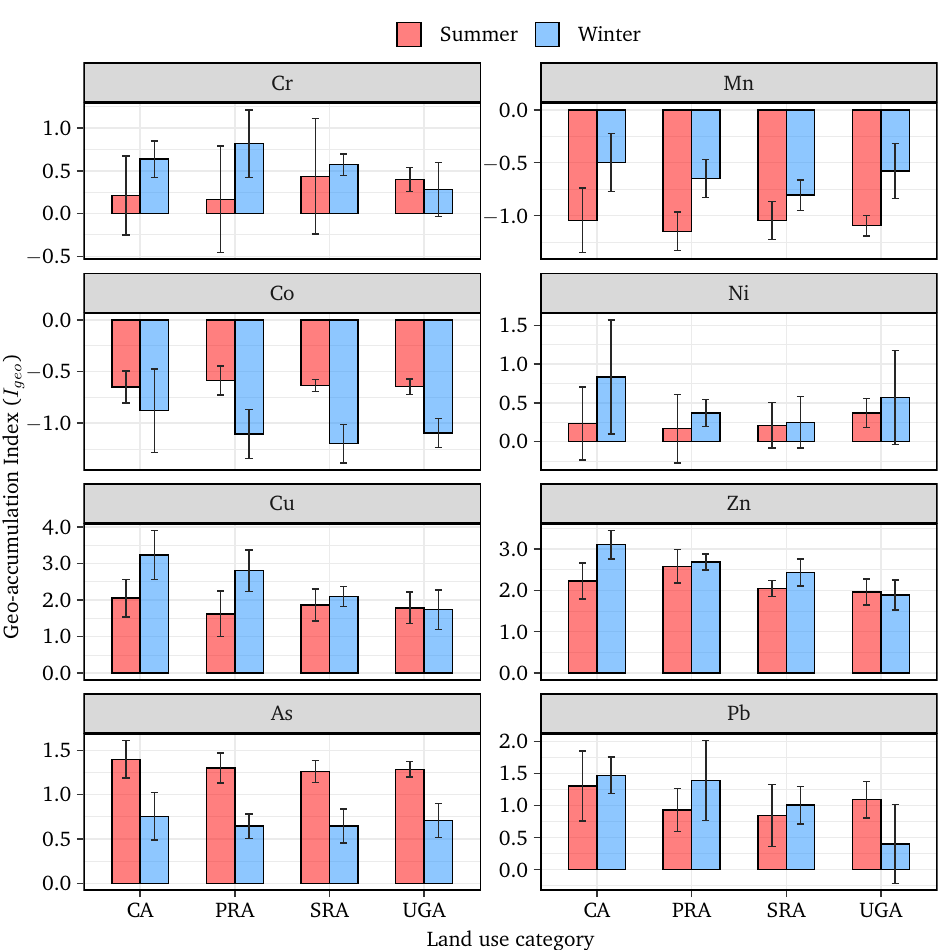
Figure 5. Geo-accumulation index ( I geo ) of heavy metals in Dhaka city for different land-use cate- gories. CA = commercial area, PRA = planned residential area, SRA = spontaneous residential area, and UGA = urban green area. The vertical bars represent standard